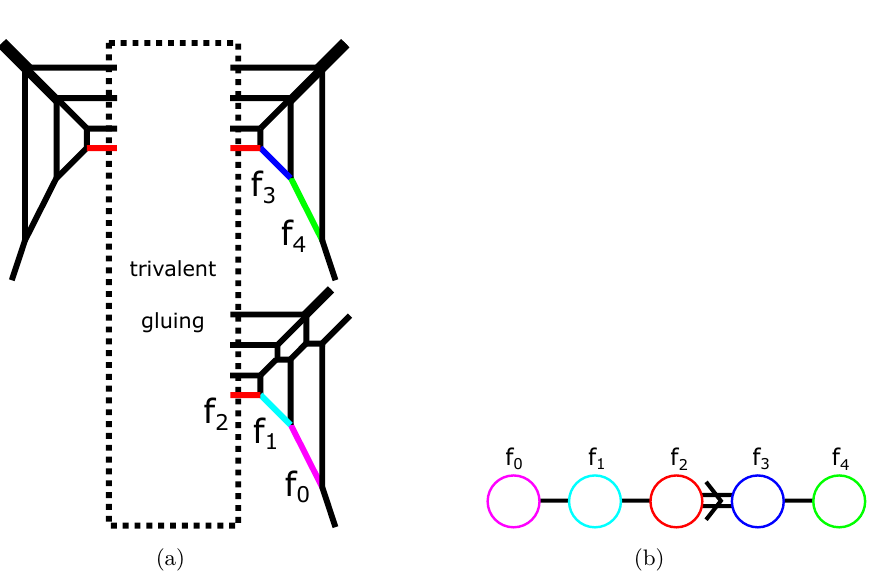
Figure 14. (a): The web diagram of the theory obtained after the Higgsing (3 , 3 , 2) . (b): The Dynkin diagram of the affine Lie algebra f (1) which is formed by the colored lines in figure 13(a). 4 The lines in magenta, cyan, red, blue and green in figure 13(a) correspond to the nodes in magenta, cyan, red, blue and green in this figure